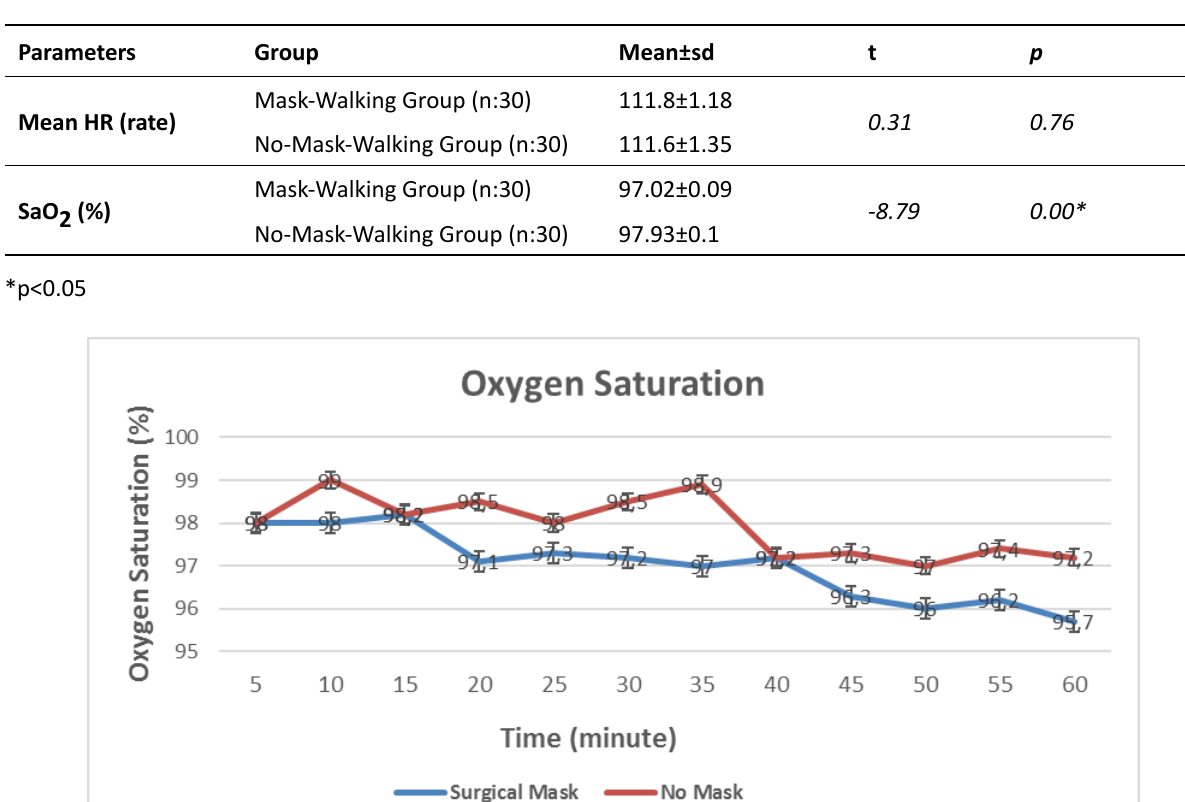
Figure 1. Mean changes in the oxygen saturation (%) values during the one-hour walking exercise performed by 30 subjects with and without a surgical face mask